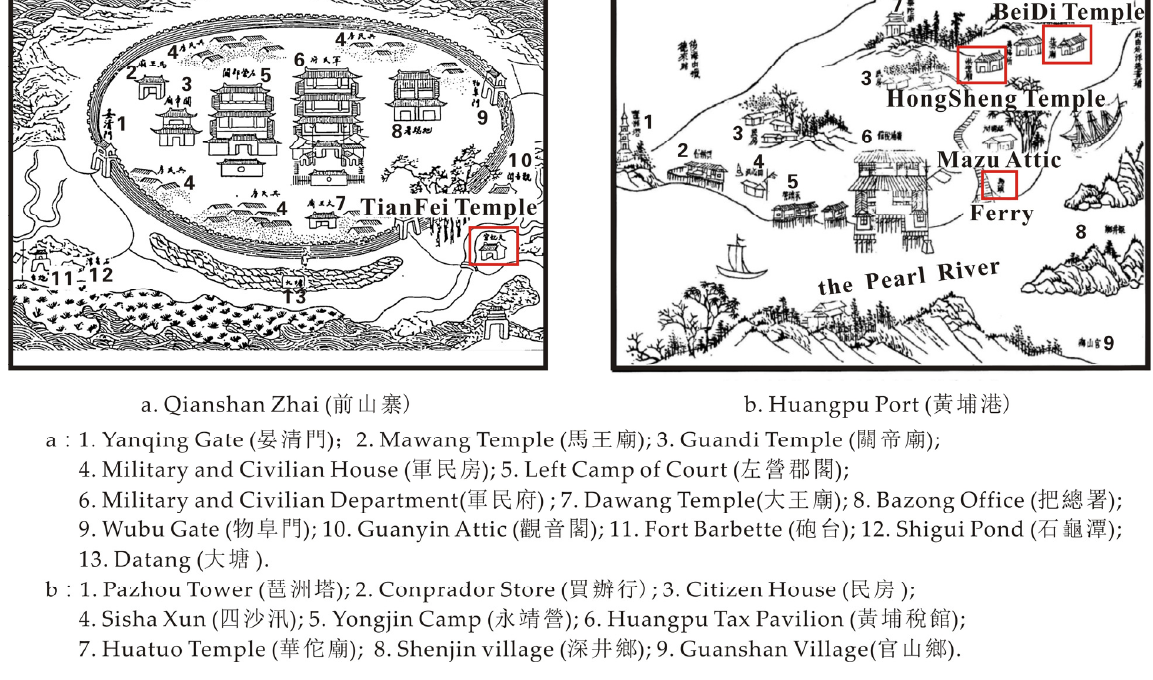
Figure 7. Two chorographic maps show the location of Water Deities’ temples.